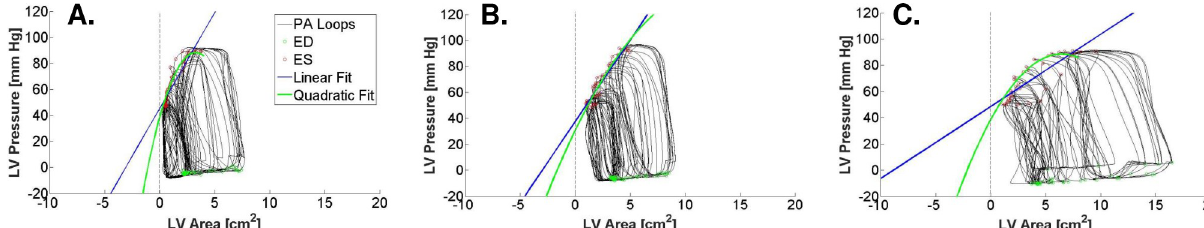
Fig 7. Representative LVP-area (LVPA) loops derived from the level set algorithm and pressure measurements along with fitted ESPAR at apex (A) , mid- ventricle (B) , and base (C) during VCO. The ESPAR was fitted with a linear function (blue) and a quadratic function (green) for comparison. The vertical dashed line represents collapse of the LV to zero volume.